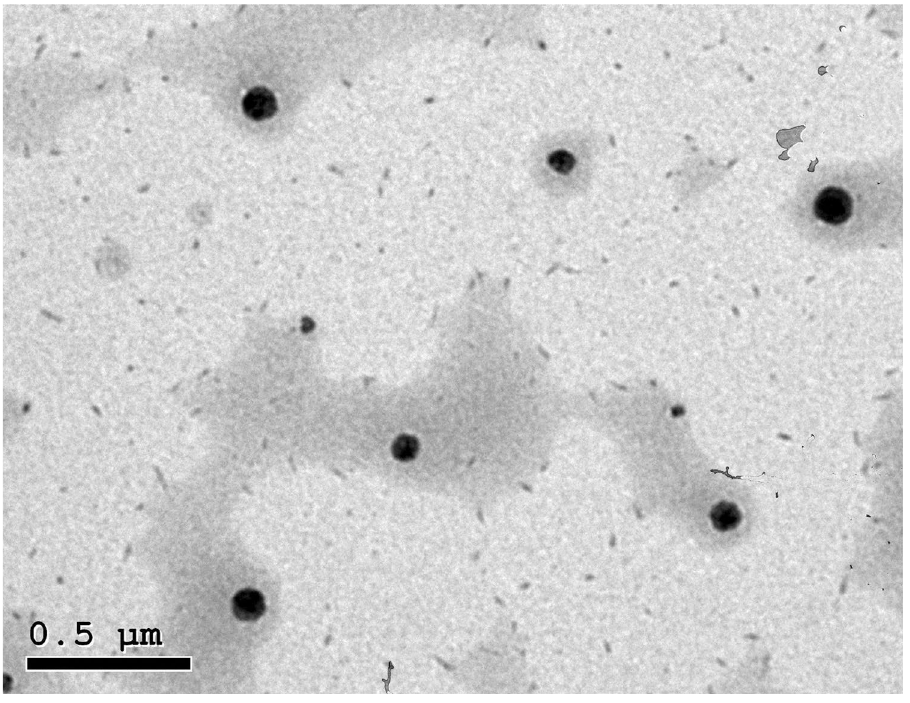
Figure 2. TEM image of CEONLC